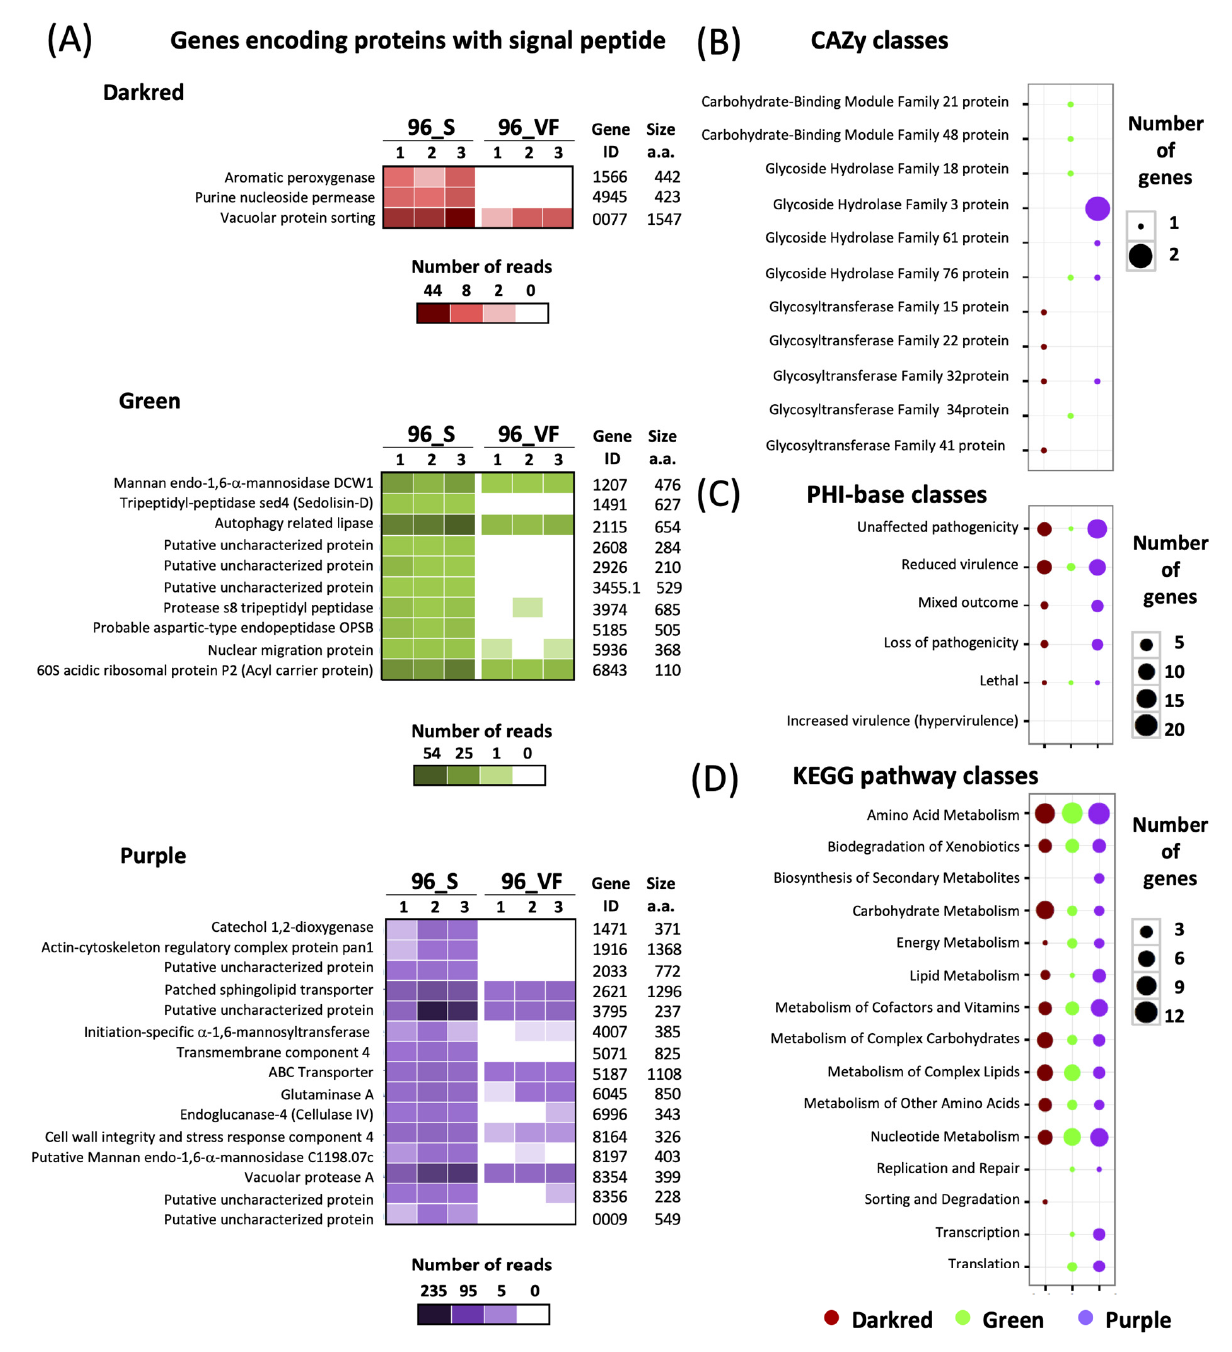
Figure 3. Annotation of genes found in weighted gene co-expression network analysis modules Darkred, Green and Purple that were associated with higher Ohiostoma novo-ulmi ssp. Americana gene expression in susceptible Ulmus americana . ( A ) Identity and expression level of genes encoding a protein with a signal peptide. Number of reads is shown for each replicate. ( B ) CAZY classes. ( C ) PHI-base classes. ( D ) Kyoto Encyclopedia of Genes and Genomes (KEGG) pathway